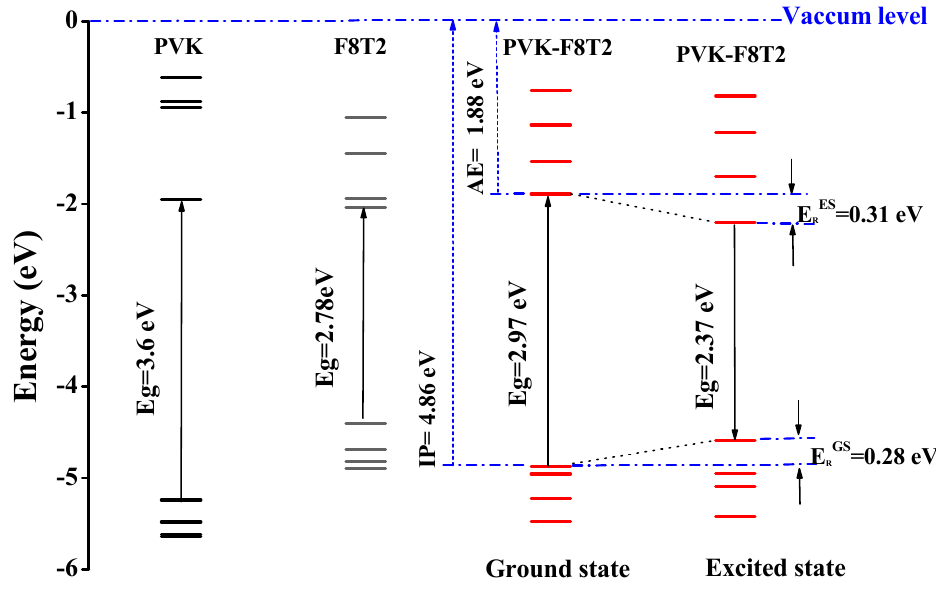
Figure 6. Electronic diagrams of PVK, F8T2 and of PVK-F8T2.